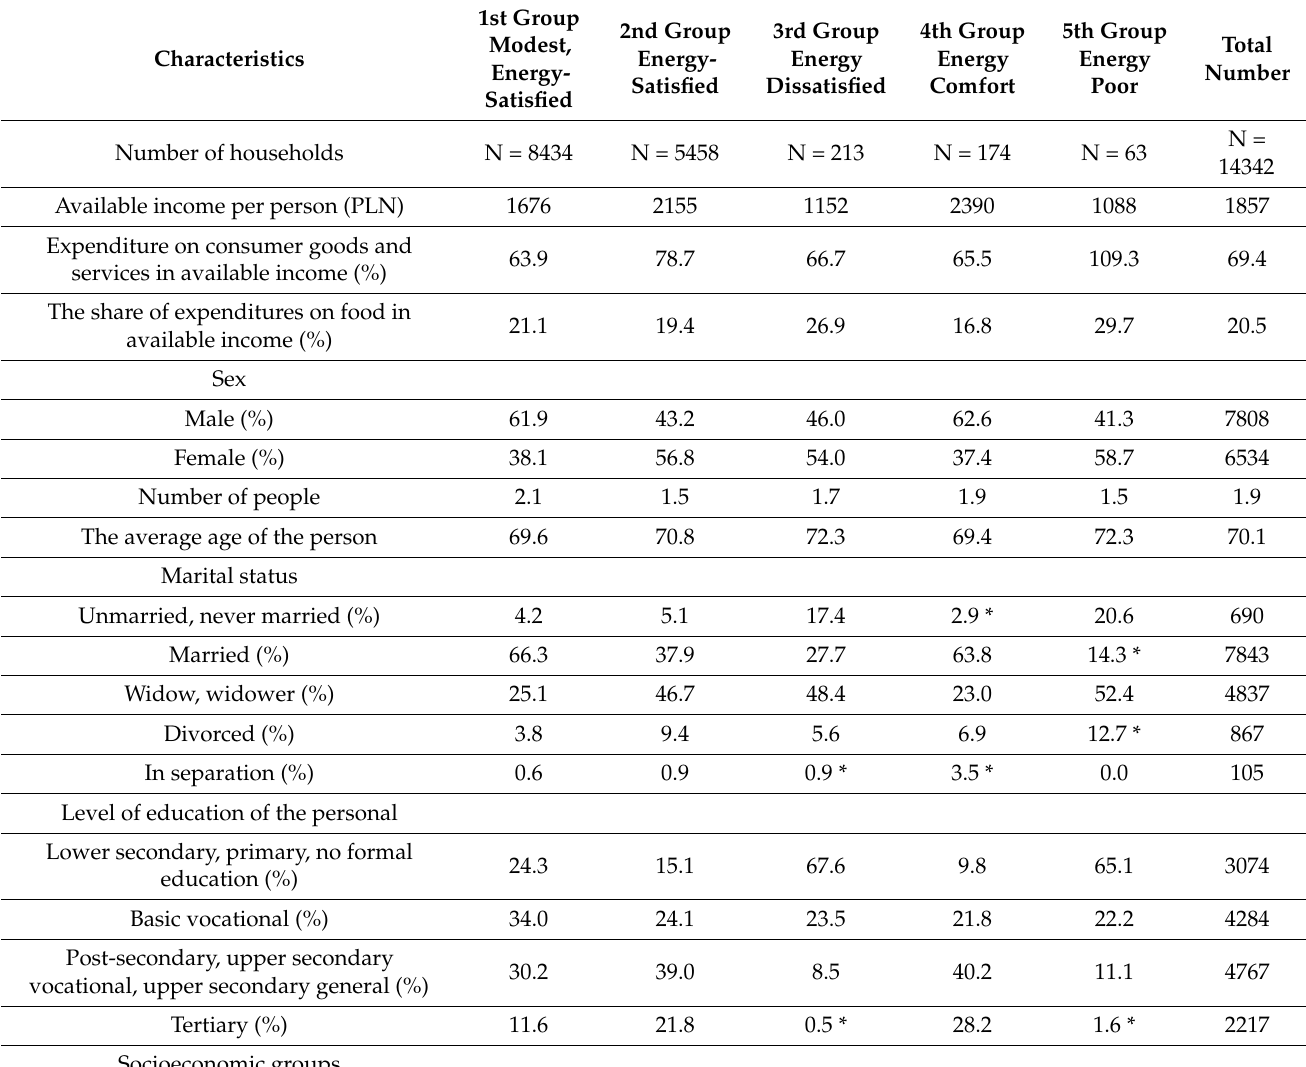
Table 5. Economic and sociodemographic characteristics of the types of households of people aged 60 and older in Poland in 2018 (as a percentage of a given